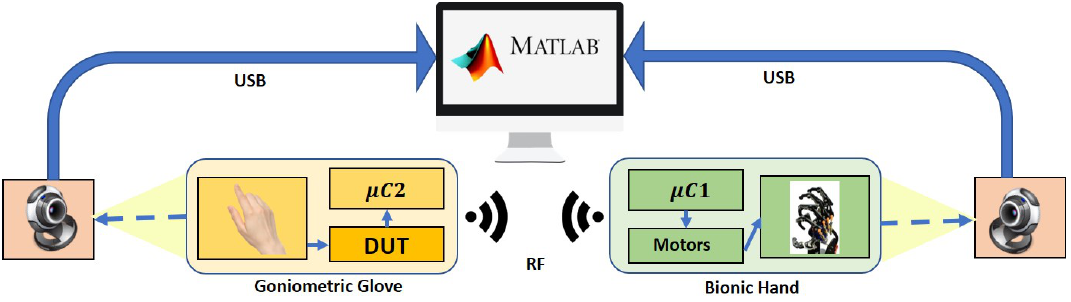
Figure 13. Schematic diagram for the experimental setup. The goniometric glove with the flex sensors is represented by "Device Under Test (DUT)", and cameras are used together with image processing in MATLAB for performance